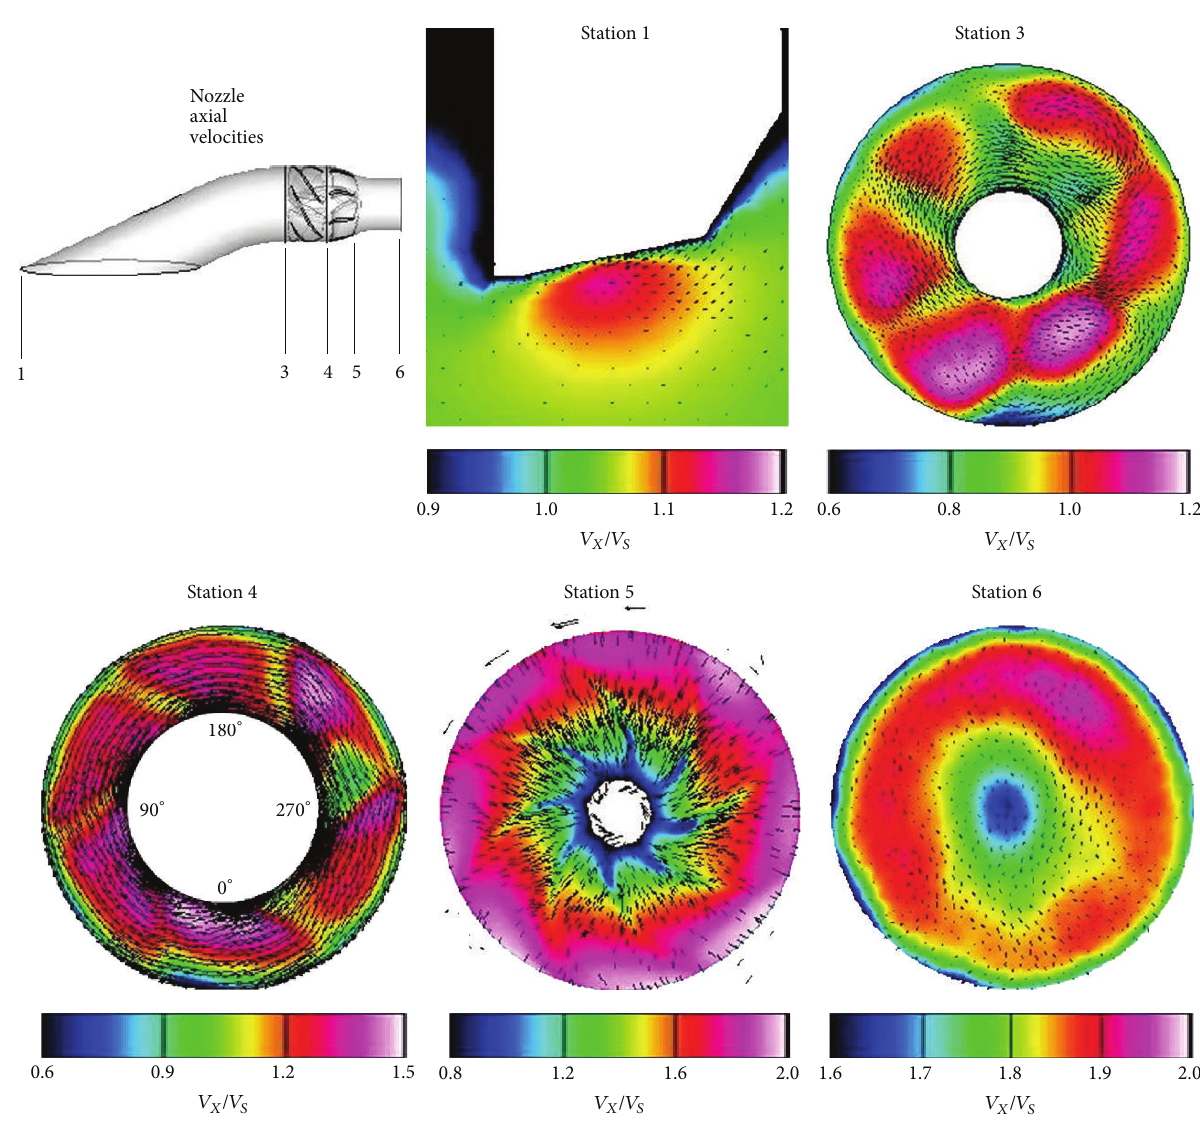
Figure 9: ITTC convention for velocity stations for the waterjet (top left, [17]) and axial velocity contours for the case of vessel speed 𝑉 𝑆 = 30 knots and a rotor speed 𝑛 = 440 rpm. View from Aft looking upstream. The rotor rotates in the clockwise